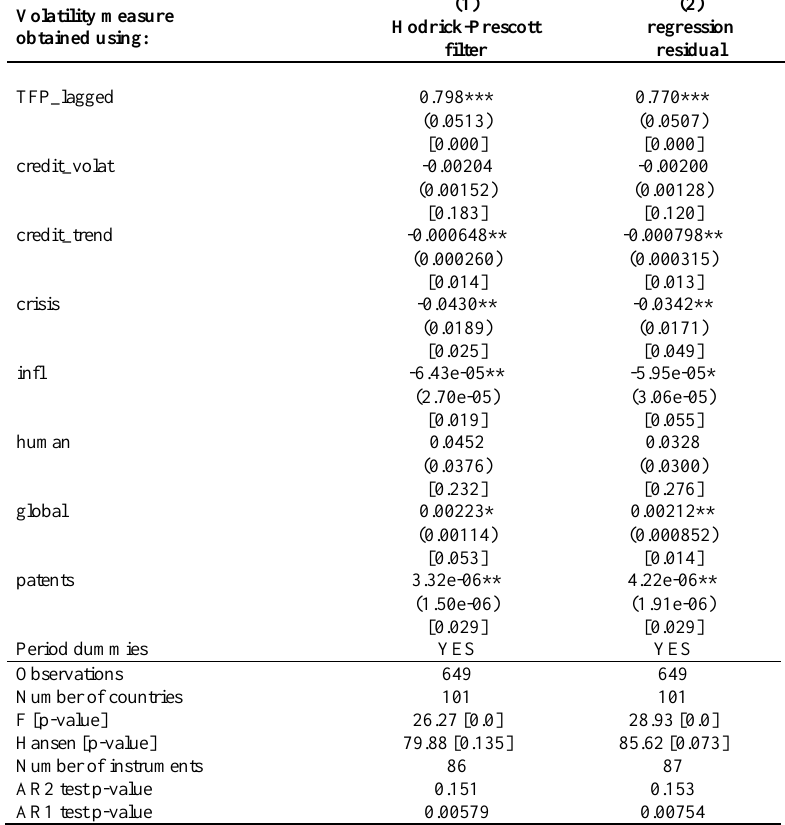
Table 1. Determinants of (the log of) TFP in the 1970–2009 period Volatility measure obtained